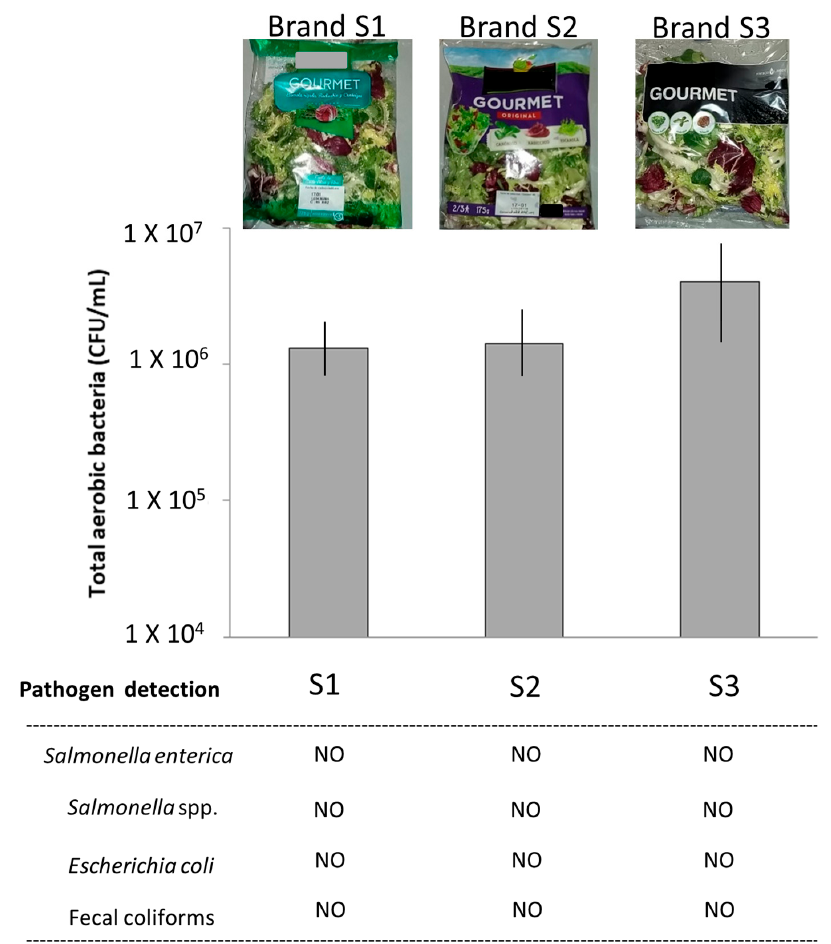
Figure 1. Microbial cultures and counts in the analyzed RTE salads. Image of the three di ff erent RTE brand samples analyzed in this study (top). From left to right, sample 1 (S1), sample 2 (S2), and sample 3 (S3). Total viable aerobic bacteria (CFU / mL) are shown for each one of the studied RTE salad brands. A total of three RTE salad brands were studied, named S1, S2, and S3. Triplicate samples were analyzed from each RTE salad brand (standard deviation of data is shown in bar chart). Detection of Salmonella, E. coli , and fecal coliforms is indicated. Cultures were performed according to validated ISO standards with chromogenic media (see methods for details).